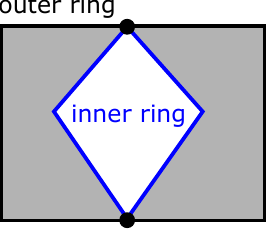
Figure 2: Inner and outer ring sharing two points, resulting in a